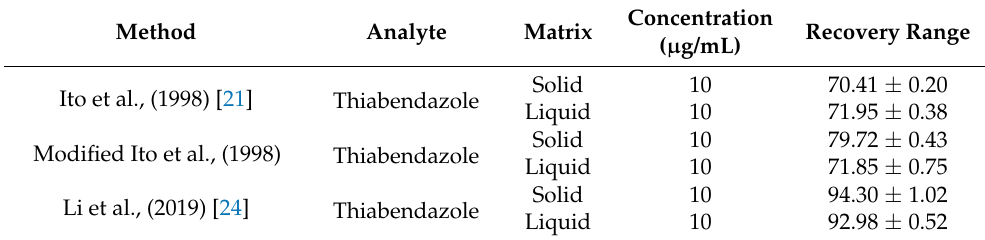
Table 2. Analyte recovery rates using the modified sample preparation